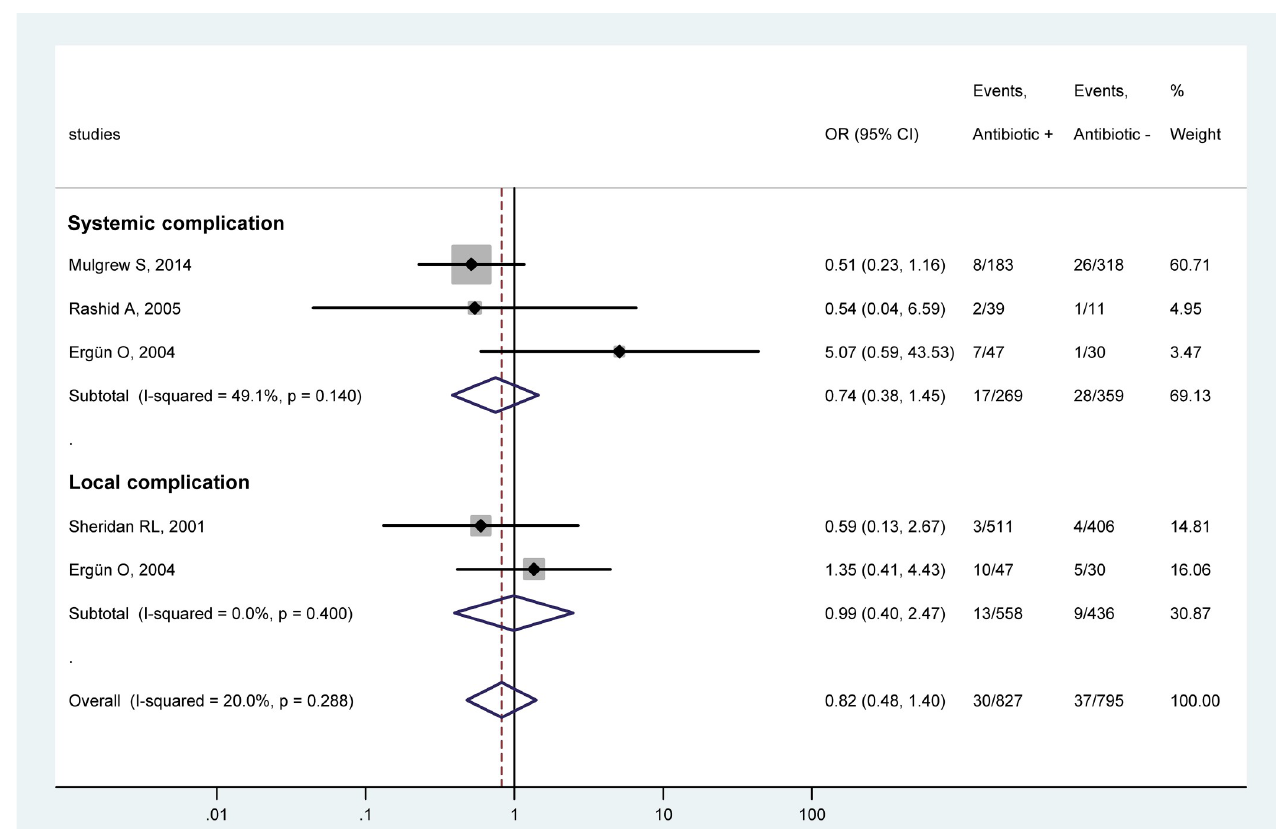
Fig 2. Forest plot of the odds ratios (ORs) for systemic and local subgroups of infectious complications in pediatric patients with burn injuries who received systemic antibiotic prophylaxis compared to those who did not. Here, and in Figs 3–5, black circles represent the OR for each study, while the left and right horizontal arms of the circles indicate the corresponding 95% confidence intervals (CI) for the OR. The size of the gray box is proportional to the sample size of the study; bigger box represents larger sample size, thus bigger relative weight of the study, and vice versa. The diamonds represent the average OR calculated from the ORs of the individual studies in a subgroup (top and middle) and in all studies (bottom). The left and right vertices of the diamonds represent the 95% CI of the average ORs. The vertical dashed line is determined by the low and top vertices of the bottom diamond and indicates the value of the average OR of all studies in the forest plot. An OR lesser than 1 indicates that the use of systemic antibiotic prophylaxis decreased the chance for infectious complications, whereas an OR higher than 1 indicates an increased chance for infections in the antibiotic-treated children.